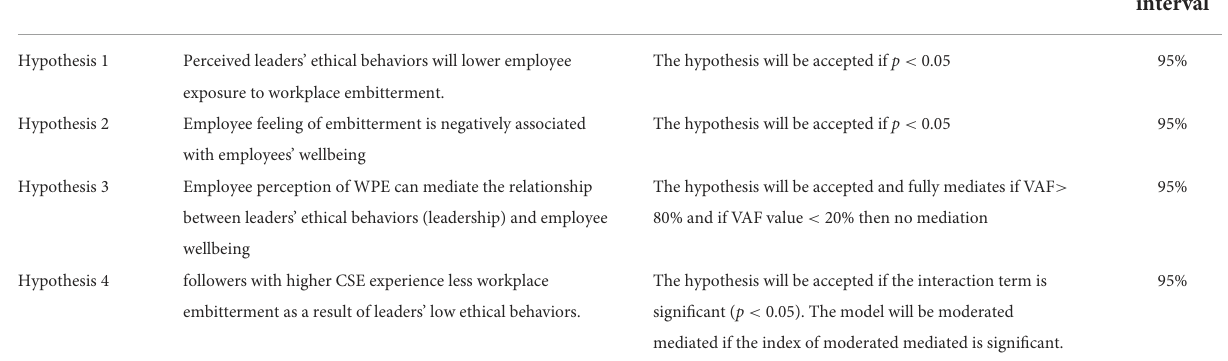
TABLE 1 Hypothesis and its acceptance criteria. Hypothesis Acceptance criteria